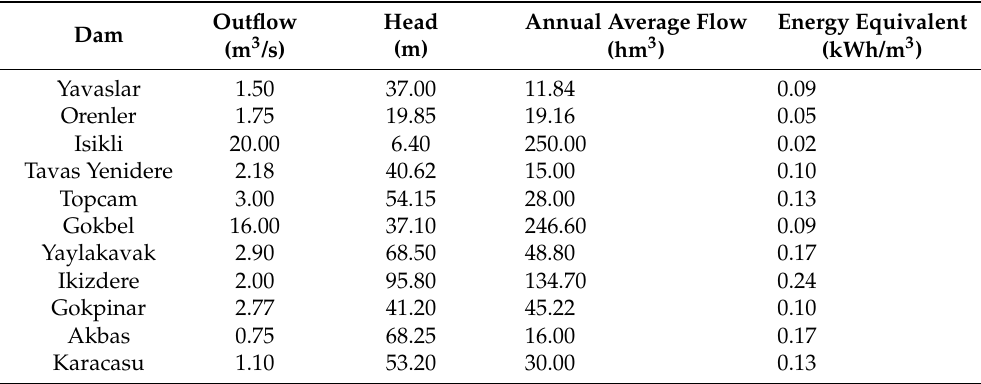
Figure 1. Map of the B. Menderes River Basin as configured in WEAP. Table 2. Energy Specifications of the 11